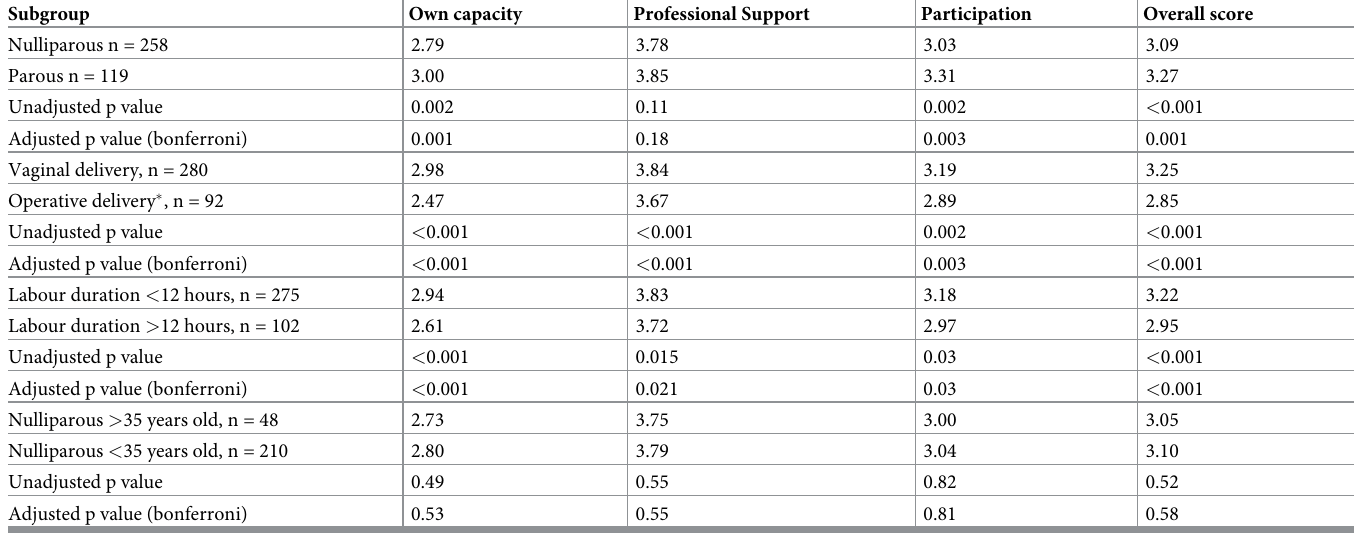
Table 6. Differences in subscale scores and overall score of the CEQ by different groups.